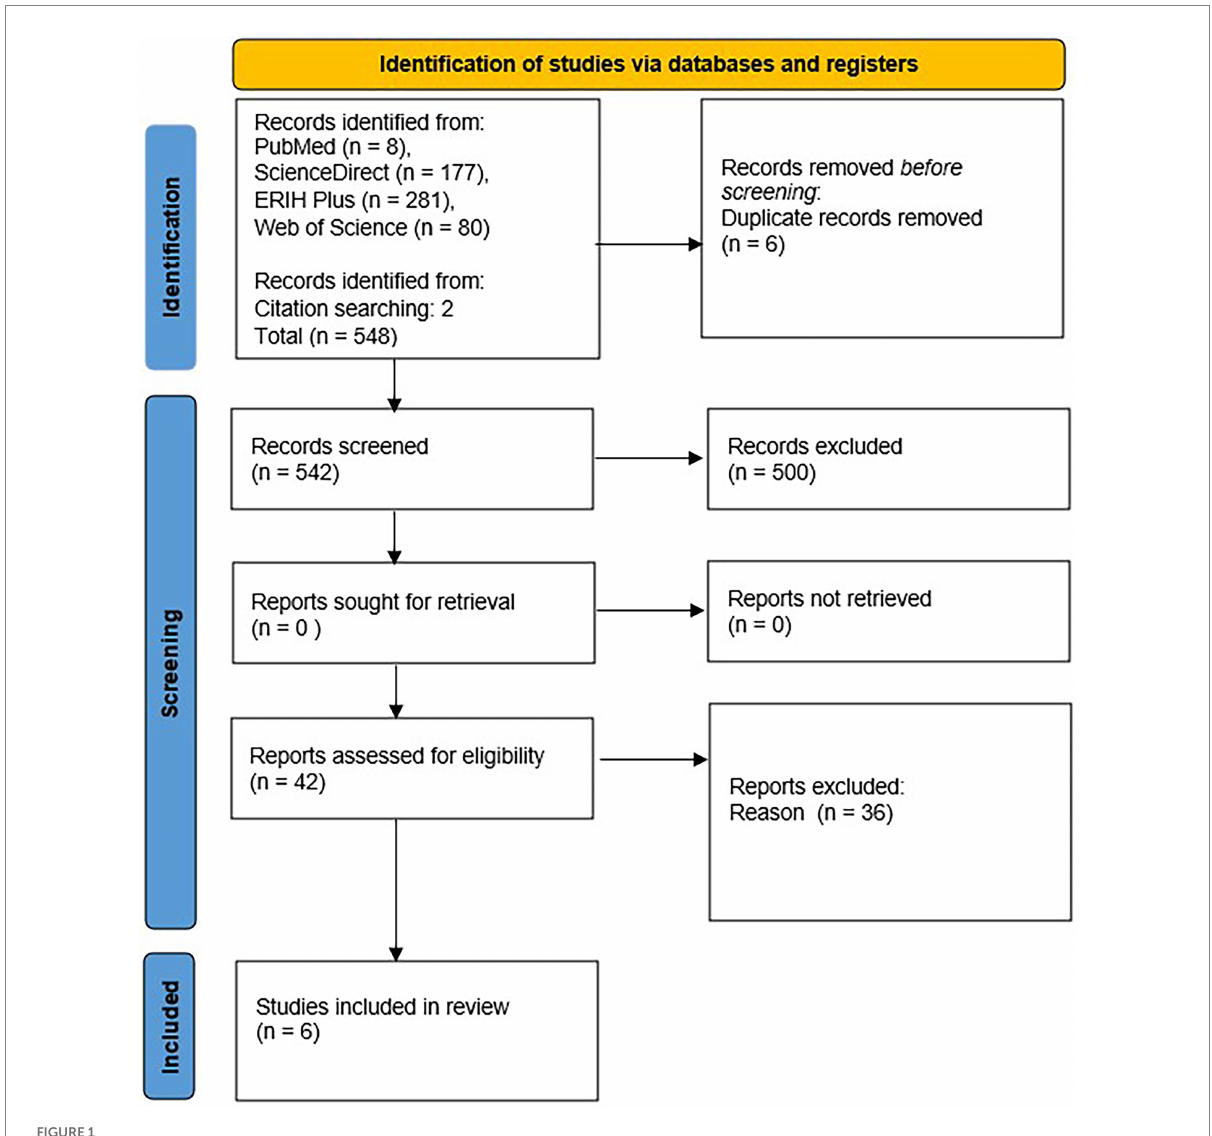
FIGURE 1 PRISMA flow diagram of the scoping review.